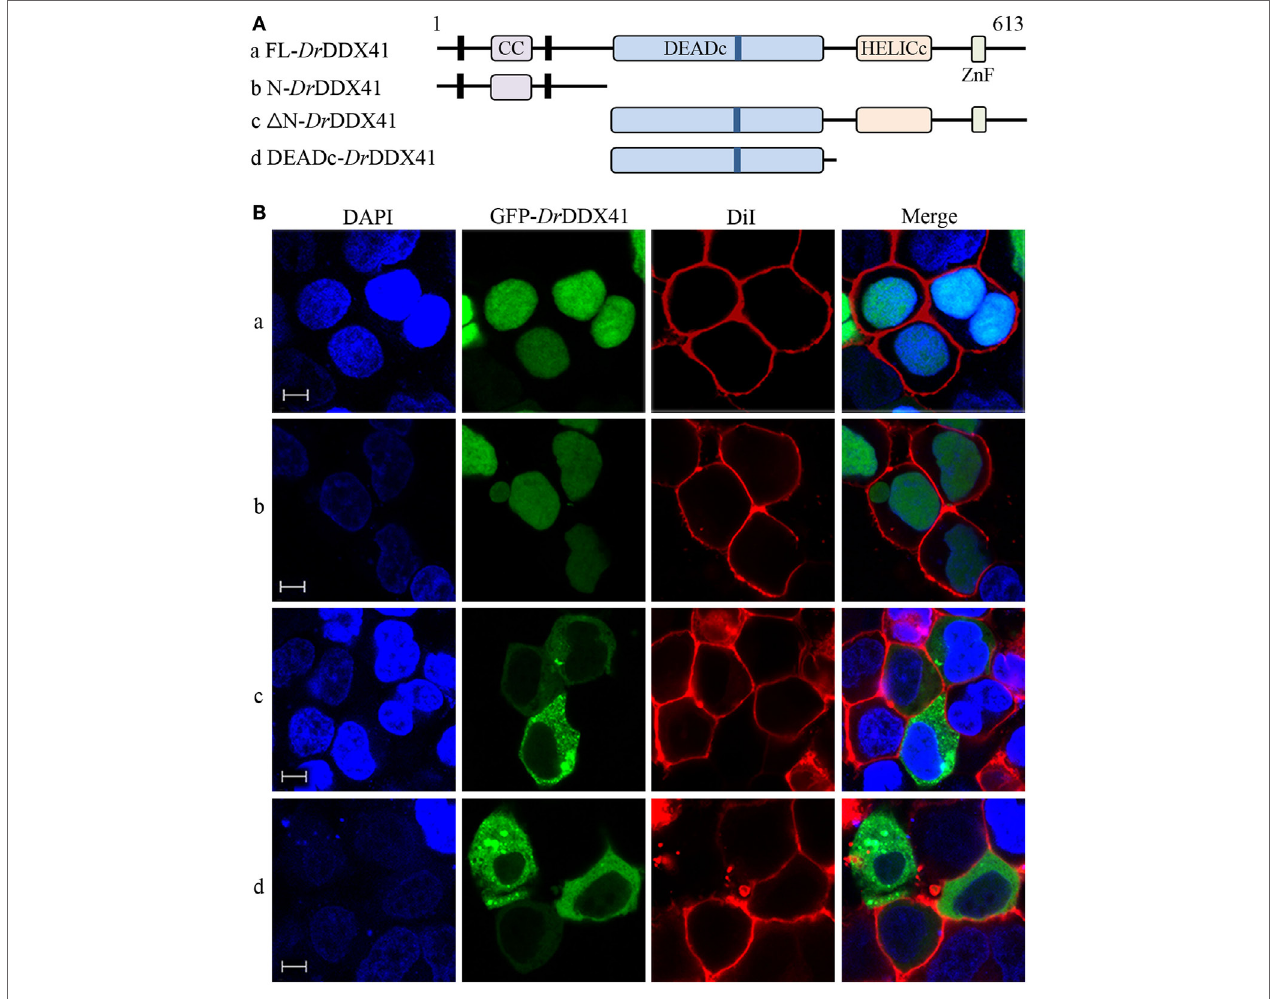
FigUre 4 | Subcellular localization of Danio rerio DDX41 ( Dr DDX41) and identification of the nuclear localization signal motifs within it. (a) Schematic diagram of full-length (FL) and Dr DDX41 mutants with the coiled-coil (CC), DEADc, HELICc, ZnF_C2HC domains, and residue numbers as indicated. The various Dr DDX41 fragments were inserted into the C-terminus of pEGFP-N1. (B) Representative images of transfected HEK293T cells. The N-terminal 190 amino acids targeted GFP to the nucleus (a,b). Deletion of this region in Dr DDX41 (191–613, c) and Dr DDX41 (191–411, d) resulting in punctate cytoplasmic staining and exclusion from the nucleus. Scale bars represent 5 µm. Images were captured under a laser-scanning confocal microscope (Zeiss LSM-710; original magnification, 630 ×